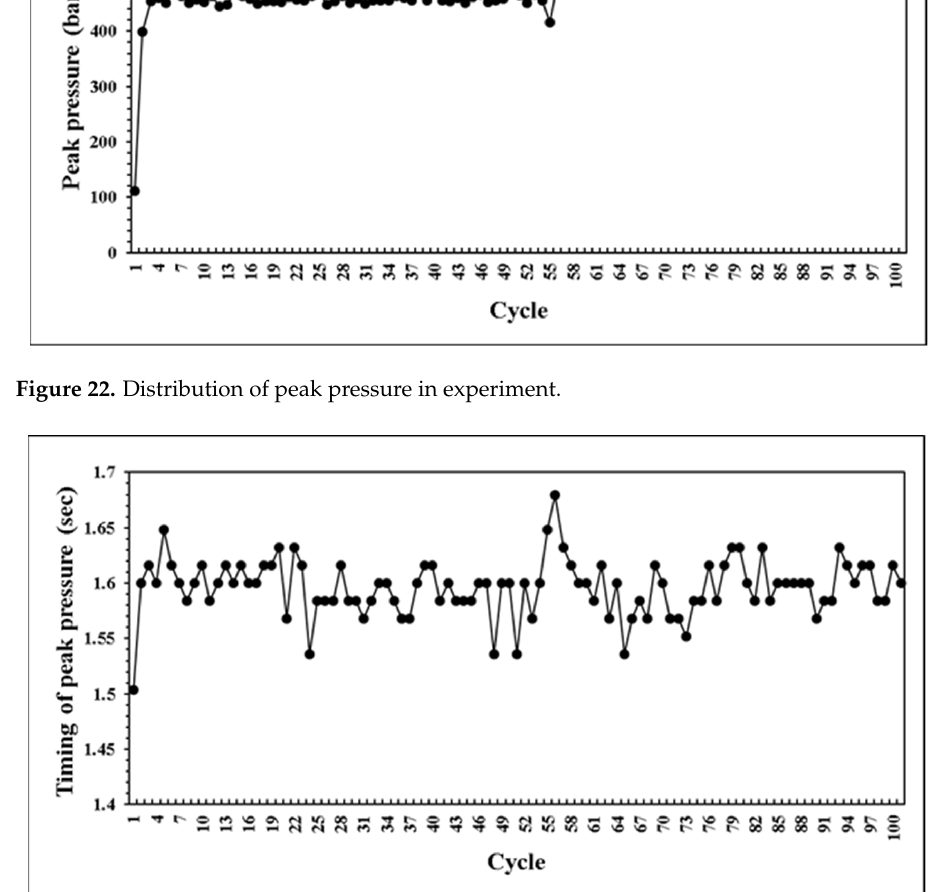
Figure 23. Distribution of timing of peak pressure in experiment.